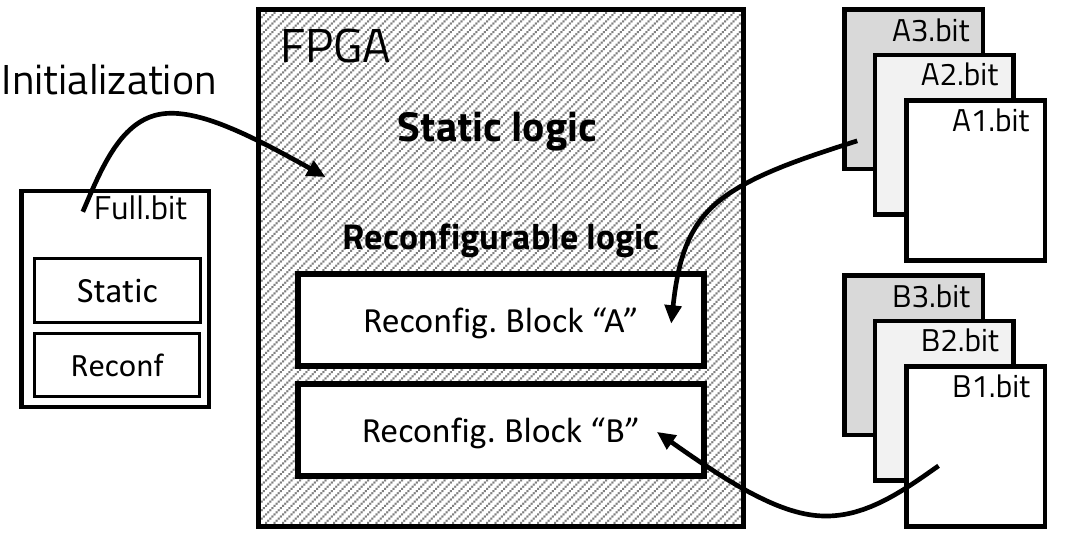
Figure 2. Dynamic partial